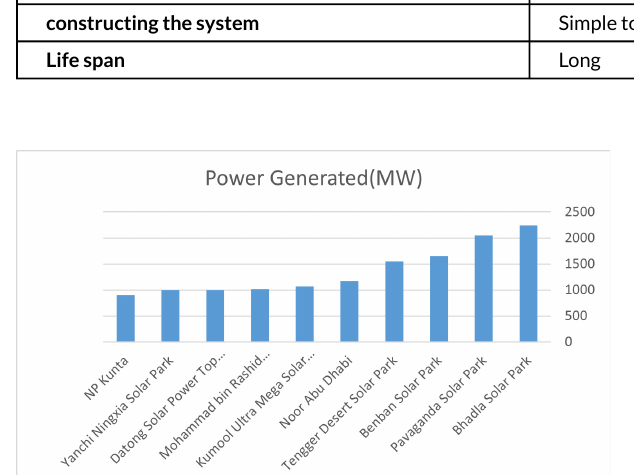
Figure 8. The world’s ten largest solar power plants